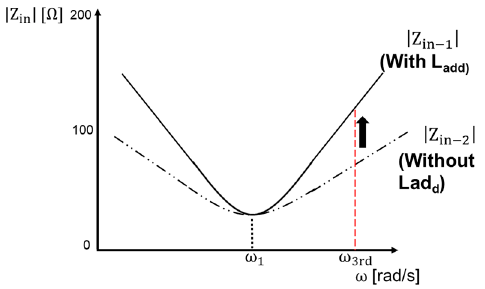
Figure 9. Equivalent input impedance of Rx side viewed from Rx equivalent source.